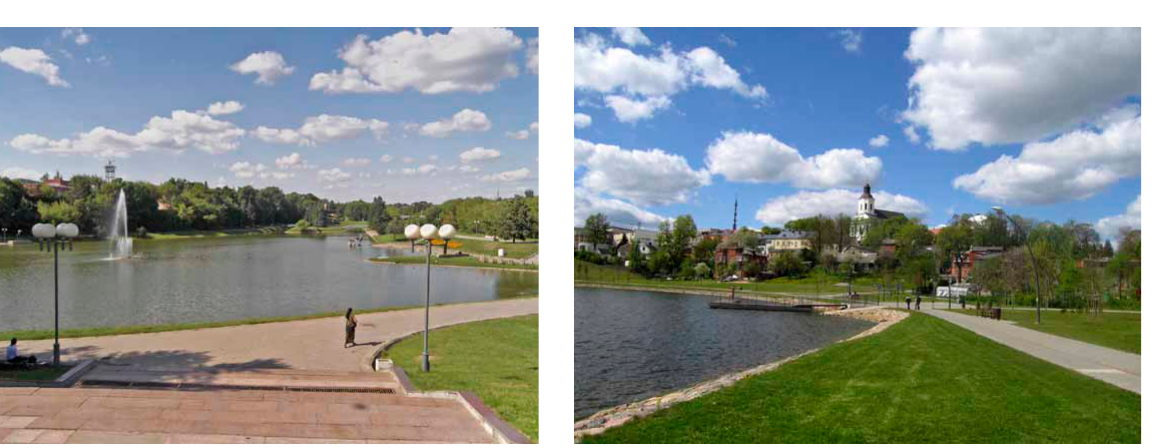
fig. 15. a significant component of the spatial structure of the city of Panevėžys is the public space near the old watercourse of the river nevėžis. It enriches townscape and creates its identity. l. Dringelis photo